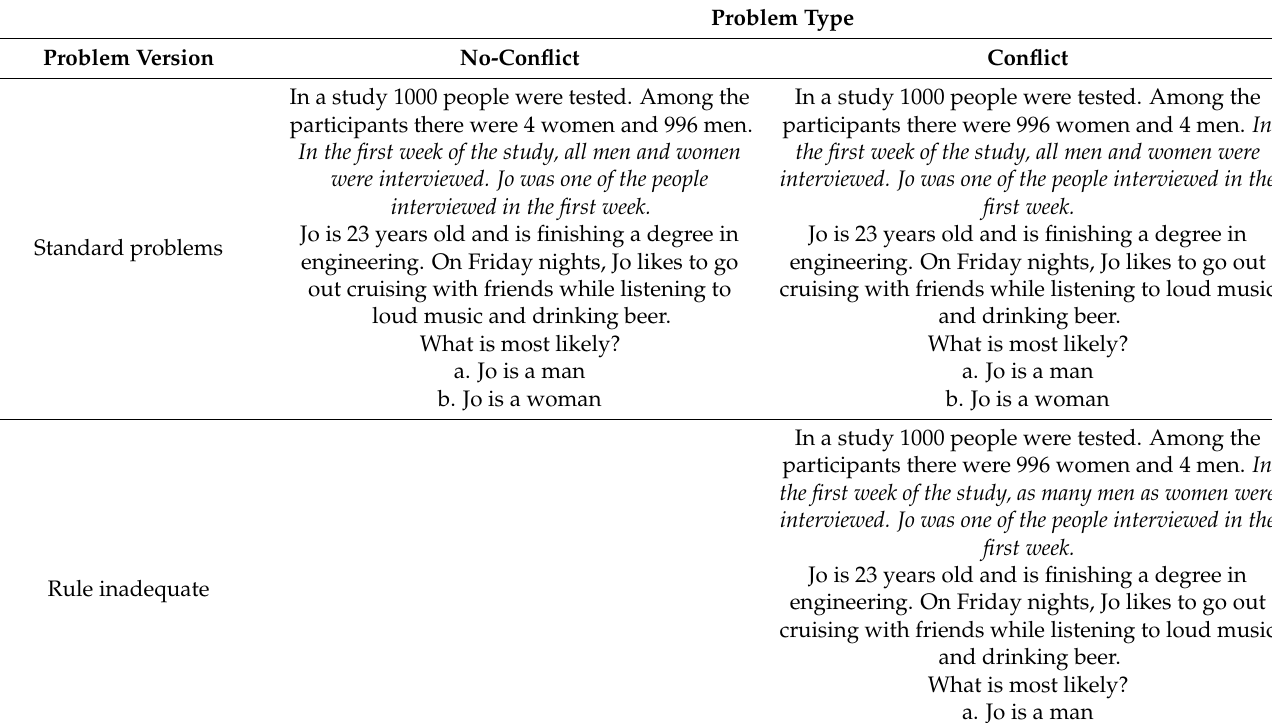
Table A3. Examples for all variations of problems used in Experiment